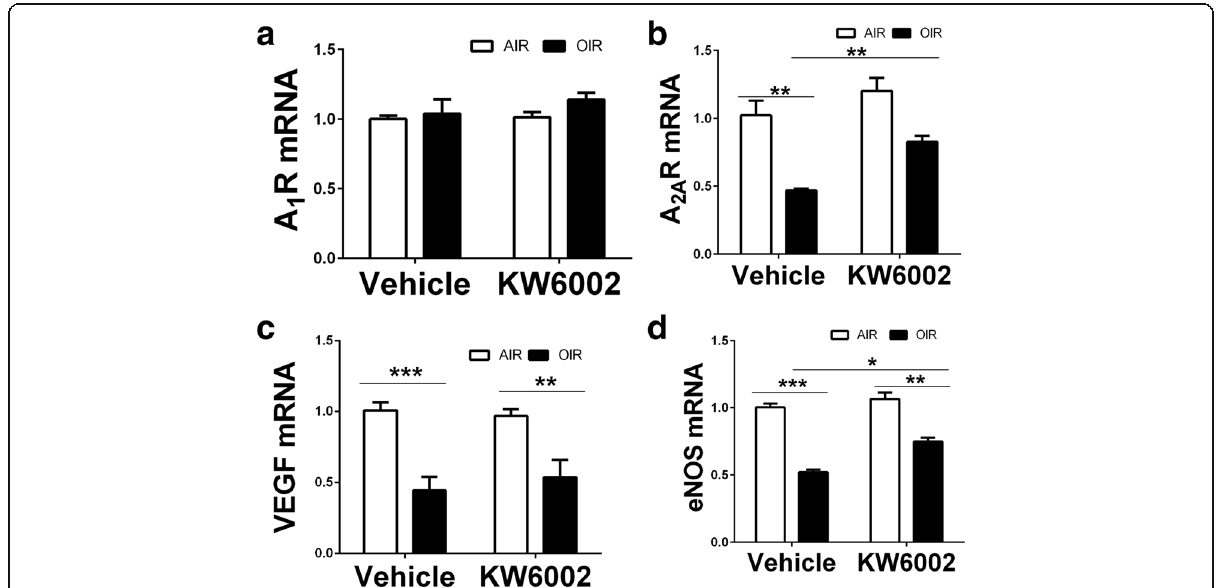
Fig. 6 KW6002 treatment reversed hyperoxia-induced reduction of the mRNAs for A 2A R and eNOS at P12. Retina of OIR and room air was dissected and harvested at P12 in retina after KW6002 or vehicle treatment (P7 – 12) and A 2A R and A 1 R mRNAs as well as the mRNAs for VEGF and eNOS were determined by qPCR analysis. Compared to the room air group, A 1 R was affected by neither to hyperoxia or KW6002 treatment ( a ) whereas the mRNAs for A 2A R, VEGF and eNOS were reduced by hyperoxic exposure. KW6002 treatment reversed the reduction of A 2A R mRNA and eNOS by hyperoxia ( b , c , d ). n =6/group * p <0.05, ** p <0.01, *** p <0.001, two-way ANOVA followed by Bonferroni post-hoc test or